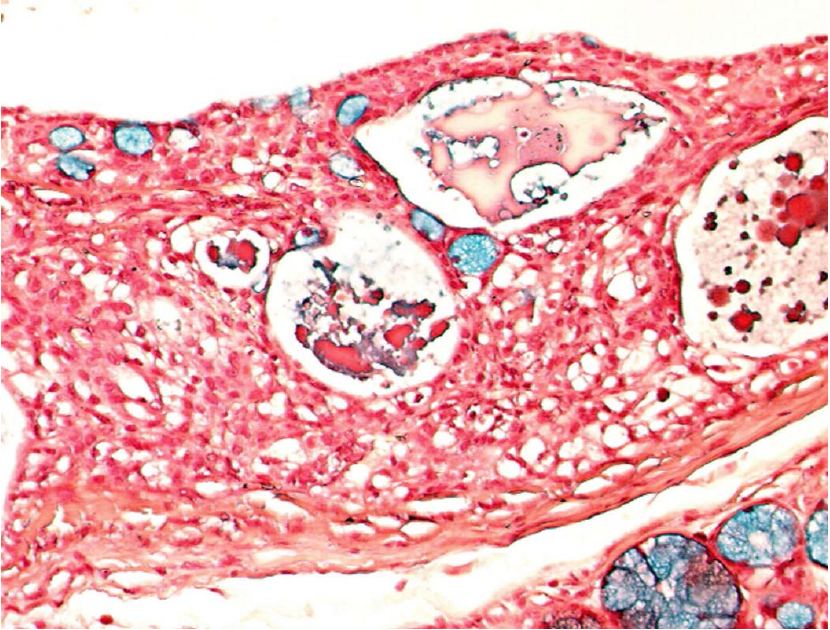
Figure 4. Epithelial cells with multi-vacuolated cytoplasms and marginated nuclei demonstrate consistent Alcian Blue positivity, indicating mucous production. (Alcian Blue, x20).